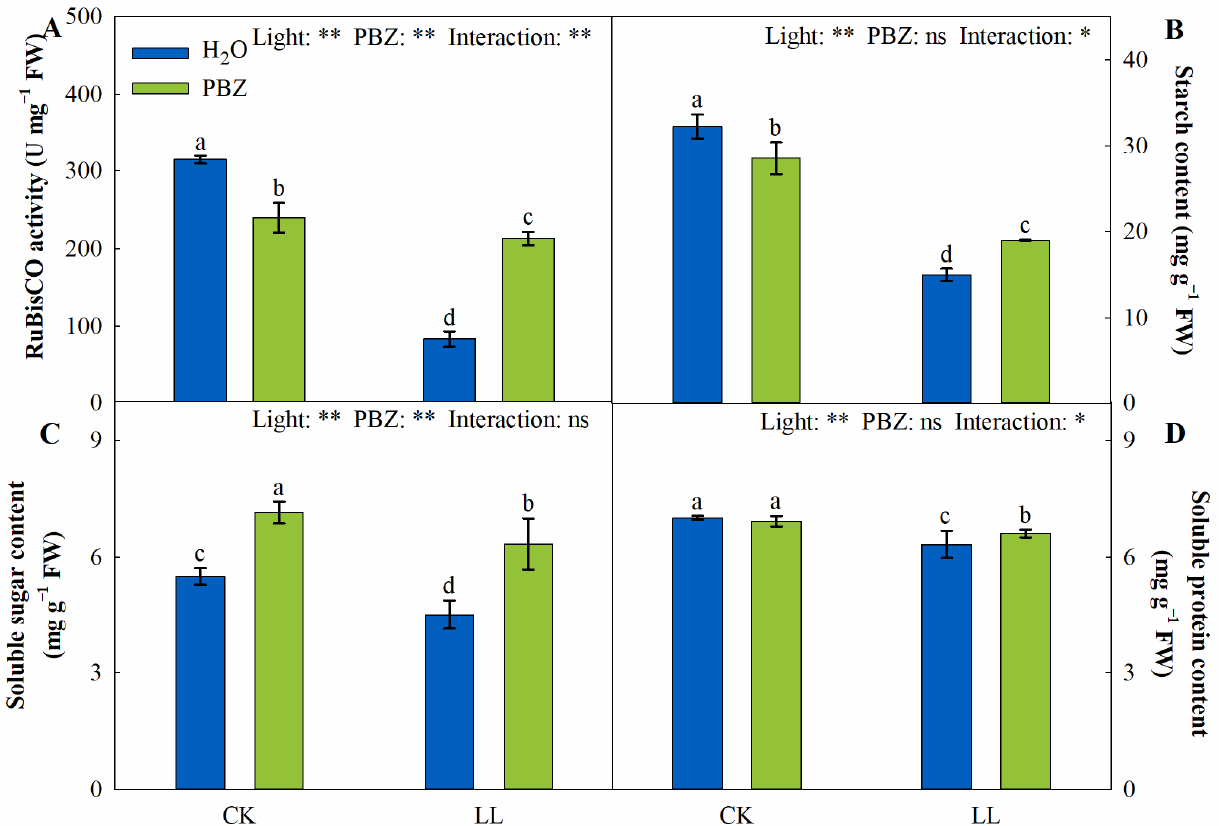
Figure 3. Changes in RuBisCO activity ( A ), starch content ( B ), soluble-sugar content ( C ), and soluble-protein content ( D ) of tall fescue leaves induced by paclobutrazol under control (CK) and LL stress. * and ** indicate significant differences at p < 0.05 and p < 0.01, respectively. ns indicates not significant. Different letters above the vertical bars indicate significant differences at p < 0.05 according to Duncan’s multiple range test.